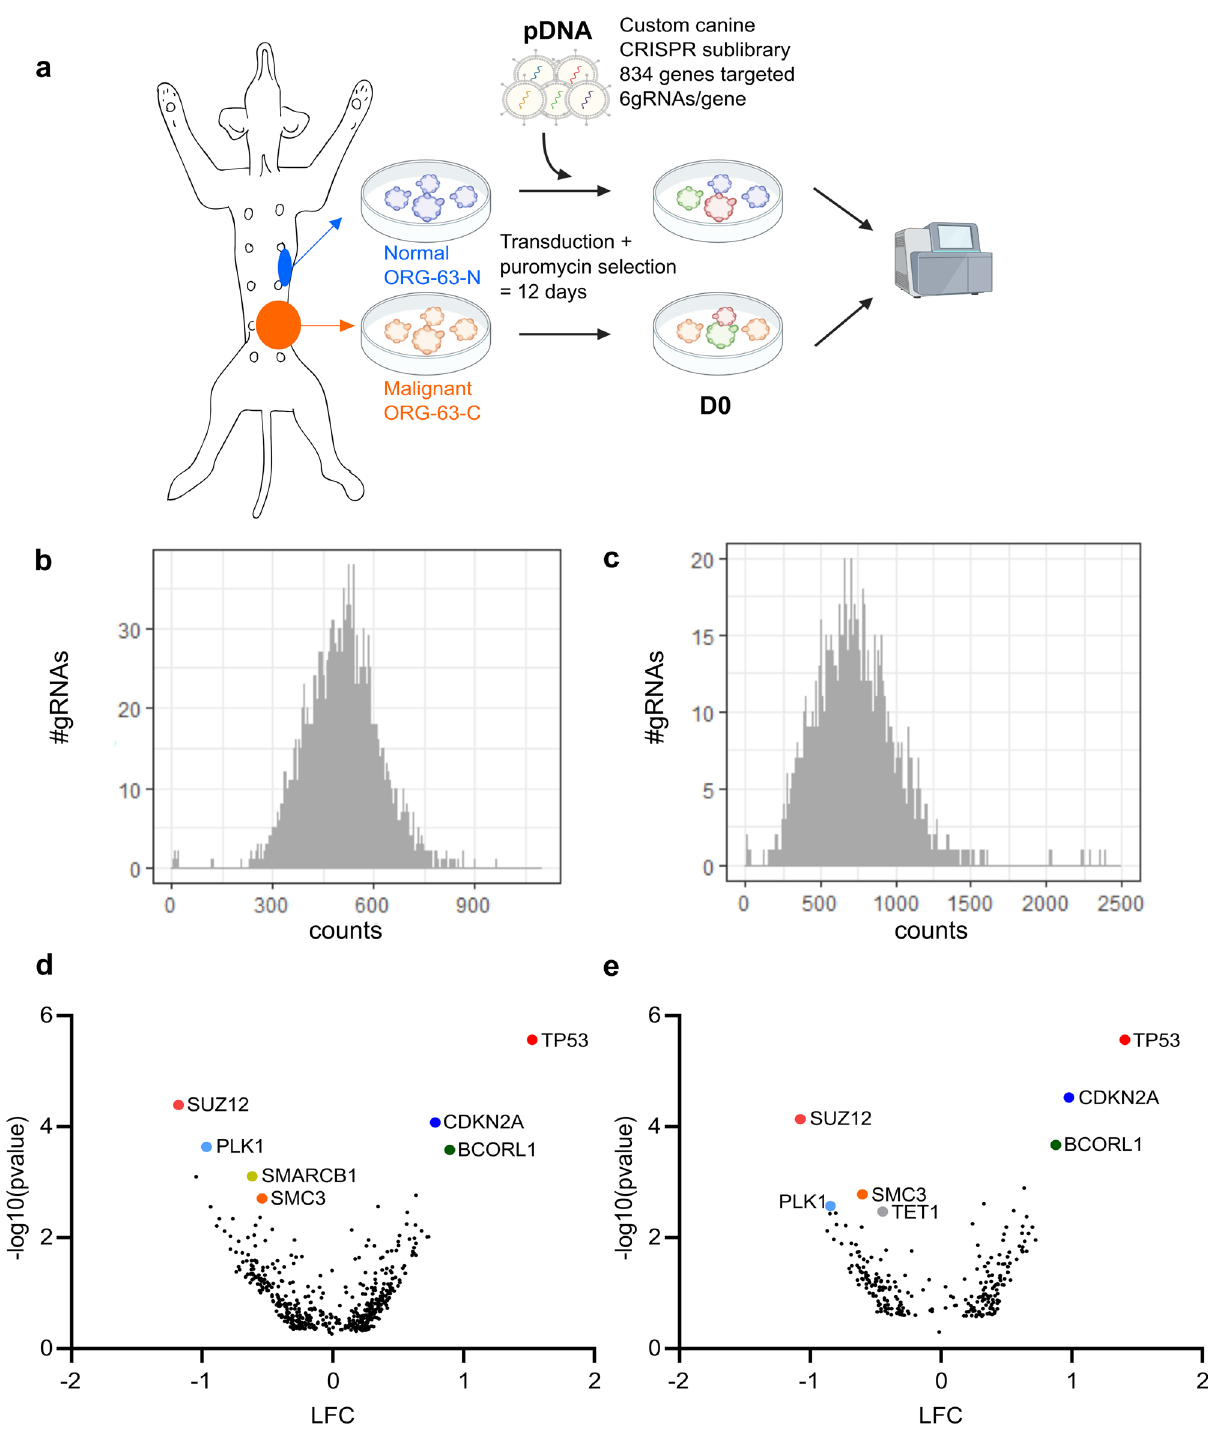
Figure 6. CMT organoids can be used to perform large-scale CRISPR/Cas9 screening. ( a ) Outline of the screen performed with a custom CRISPR/Cas9 library. ( b ) Histogram representing the distribution of the gRNA counts for the plasmid DNA (pDNA). ( c ) Histogram representing the distribution of the gRNA counts for ORG-63-N at D0 (replicate 1). ( d ) Volcano plot representing depleted (Log Fold Change = LFC < 0) and enriched (LFC > 0) genes for ORG-63-N 12 days after transduction (D0 vs. pDNA). LFC and P -values were calculated from two independent replicates with MAGeCK analysis. Each dot represents one gene for which at least three gRNAs (out of 6) were significant. Top hits are labeled with gene names. ( e ) Volcano plot representing depleted (Log Fold Change = LFC < 0) and enriched (LFC > 0) genes for ORG-63-C 12 days after transduction (D0 vs. pDNA). LFC and P -values were calculated from two independent replicates with MAGeCK analysis. Each dot represents one gene for which at least three gRNAs (out of 6) were significant. Top hits are labeled with gene